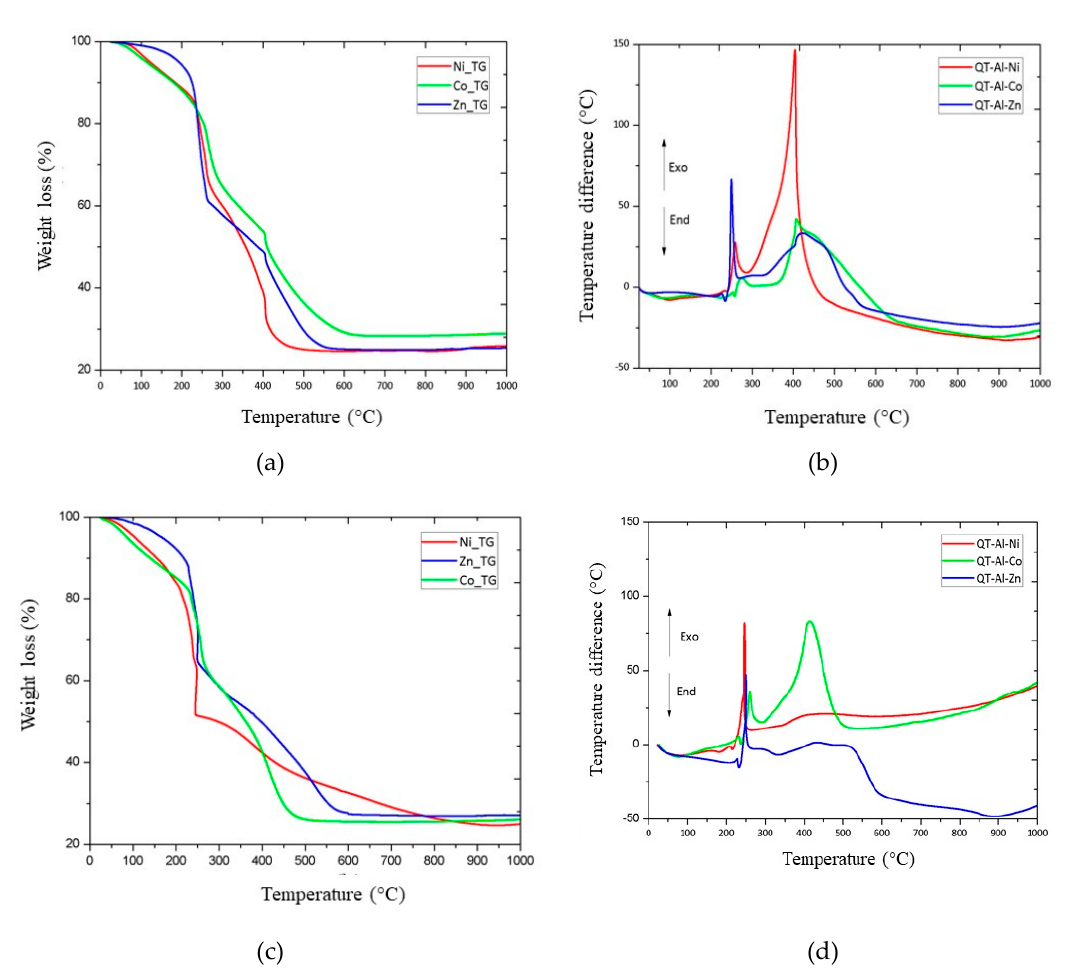
Figure 6. Thermogravimetric analysis of the samples QT-Al-Zn, QT-Al-Ni and QT-Al-Co under ( a ) air and ( c ) nitrogen. Di ff erential thermal analysis for QT-Al-Zn, QT-Al-Ni and QT-Al-Co samples under ( b ) air and ( d ) nitrogen. Obtained in the temperature range of approximately 24 to 1000 ◦ C, with a heating rate of 10 ◦ C min − 1 and synthetic air flow of 50 mL min − 1